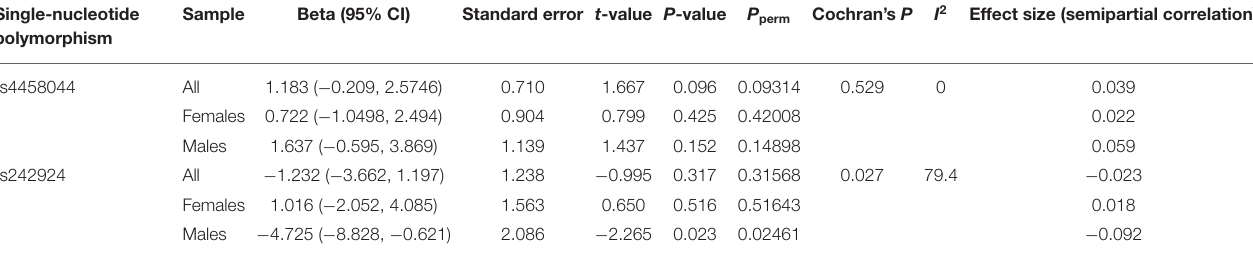
TABLE 3 | G × G effects of ADCYAP1R1–CRHR1 (rs2267735 × rs4458044 and rs242924) on posttraumatic stress disorder severity. Single-nucleotide